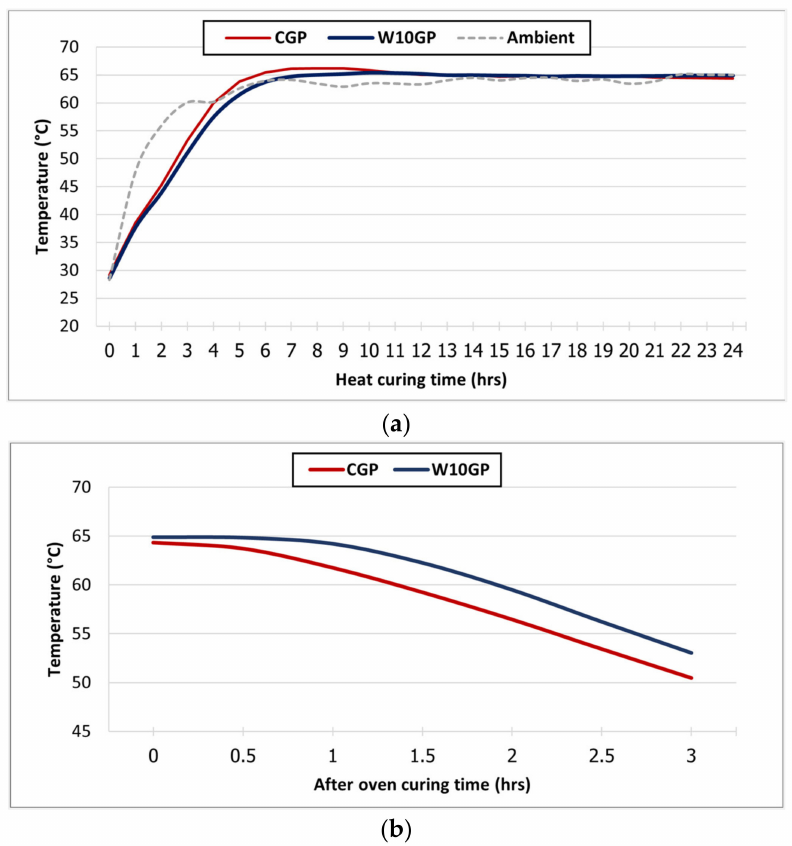
Figure 8. Temperature monitoring of ( a ) 24 h during the heat curing process and ( b ) 3 h after the heat curing process.